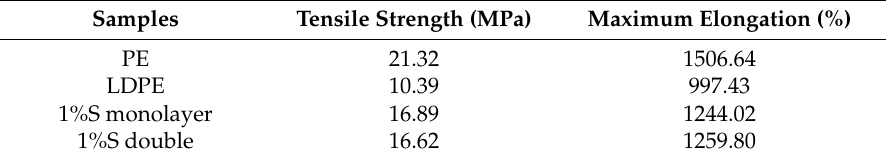
Table 1. Mechanical properties of the samples.